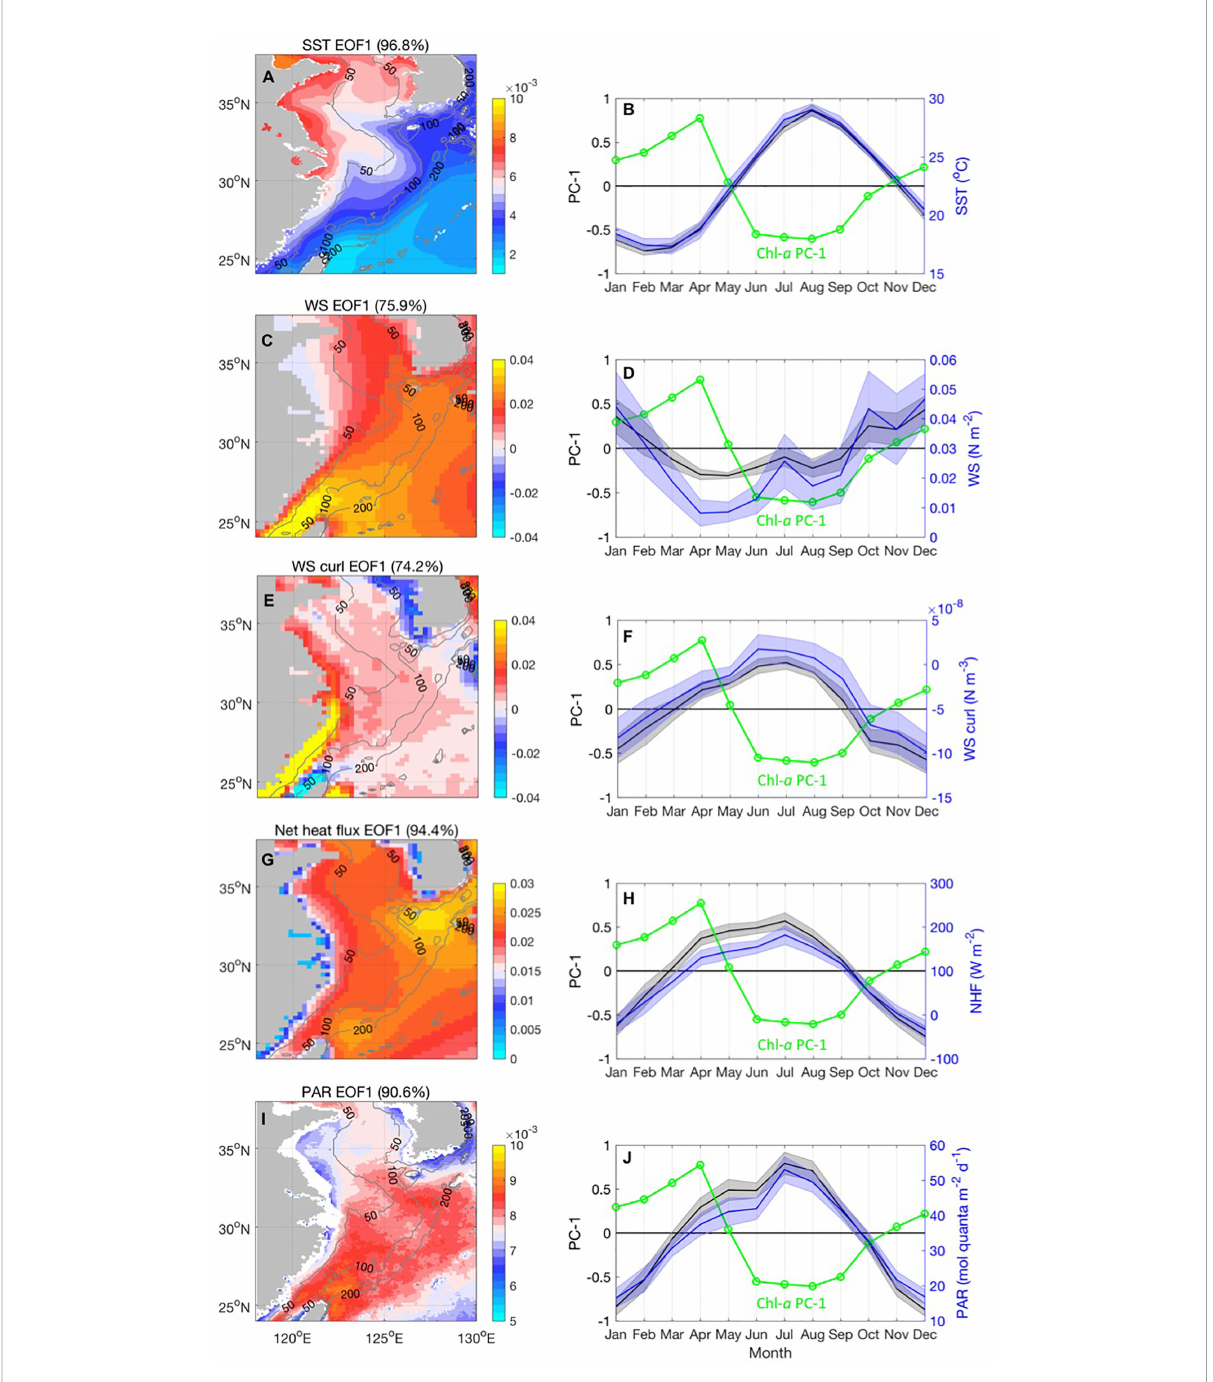
FIGURE 3 The fi rst EOF mode eigenvectors and monthly averaged temporal amplitude (PC) for SST (A, B) , wind stress magnitude (C, D) , wind stress curl (E, F) , NHF (G, H) , and PAR (I, J) . The averaged value of these variables in the box of Figure 2 was overlaid on the monthly PC time series. The monthly averaged normalized MODISA Chl -a PC-1 was plotted as a green line in each PC of the environmental